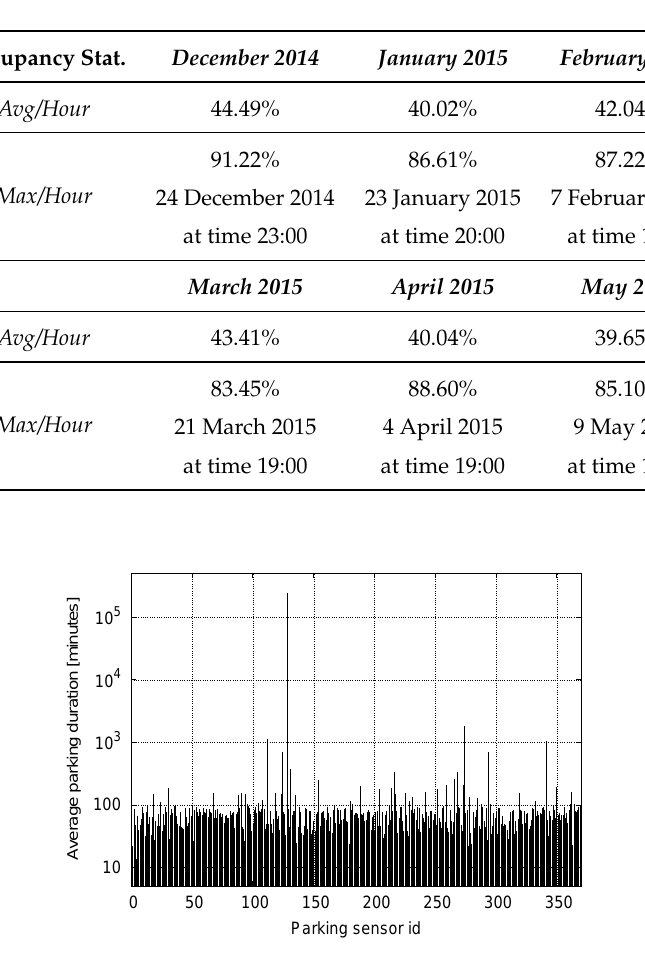
Figure 10. Average parking duration vs. parking sensor